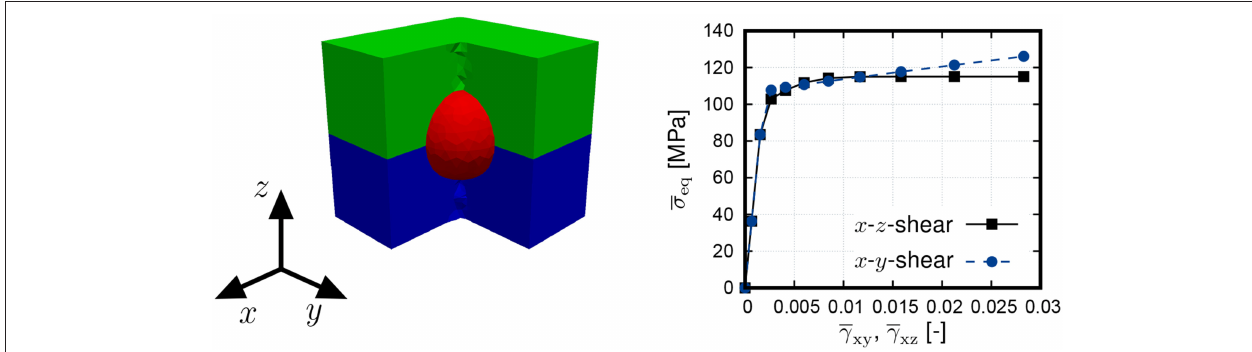
FIGURE 3 | (Left) Periodic representative volume element (RVE) of the triphasic material: layer 1 (blue; pseudo-plastic with hardening), layer 2 (green; pseudo-plastic, no hardening), and inclusion (red; linear elastic); (Right) Directional dependency of the material response.